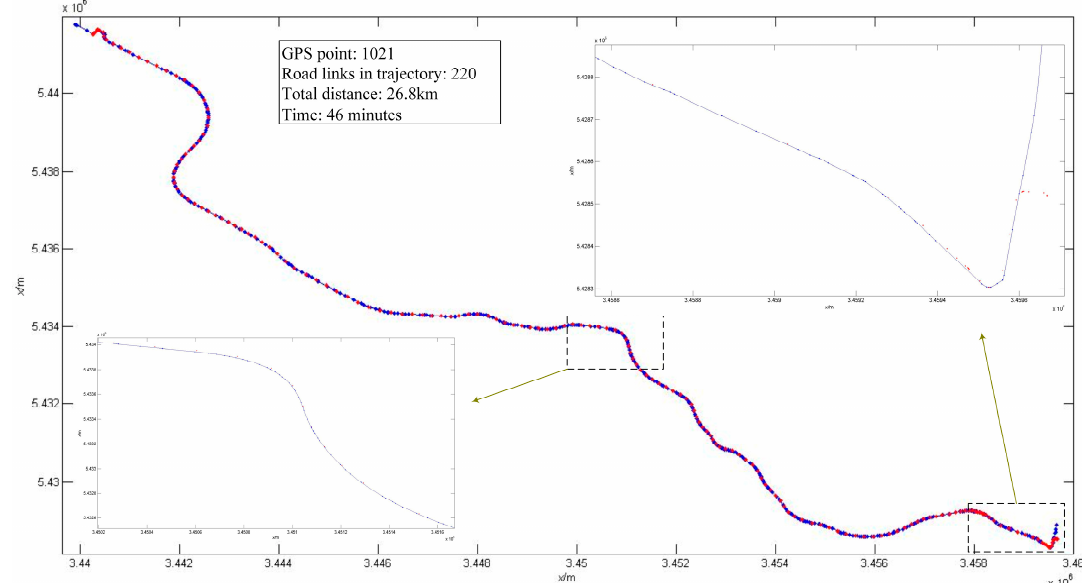
Figure 7. Visualization of these missing short road links and the GPS points.